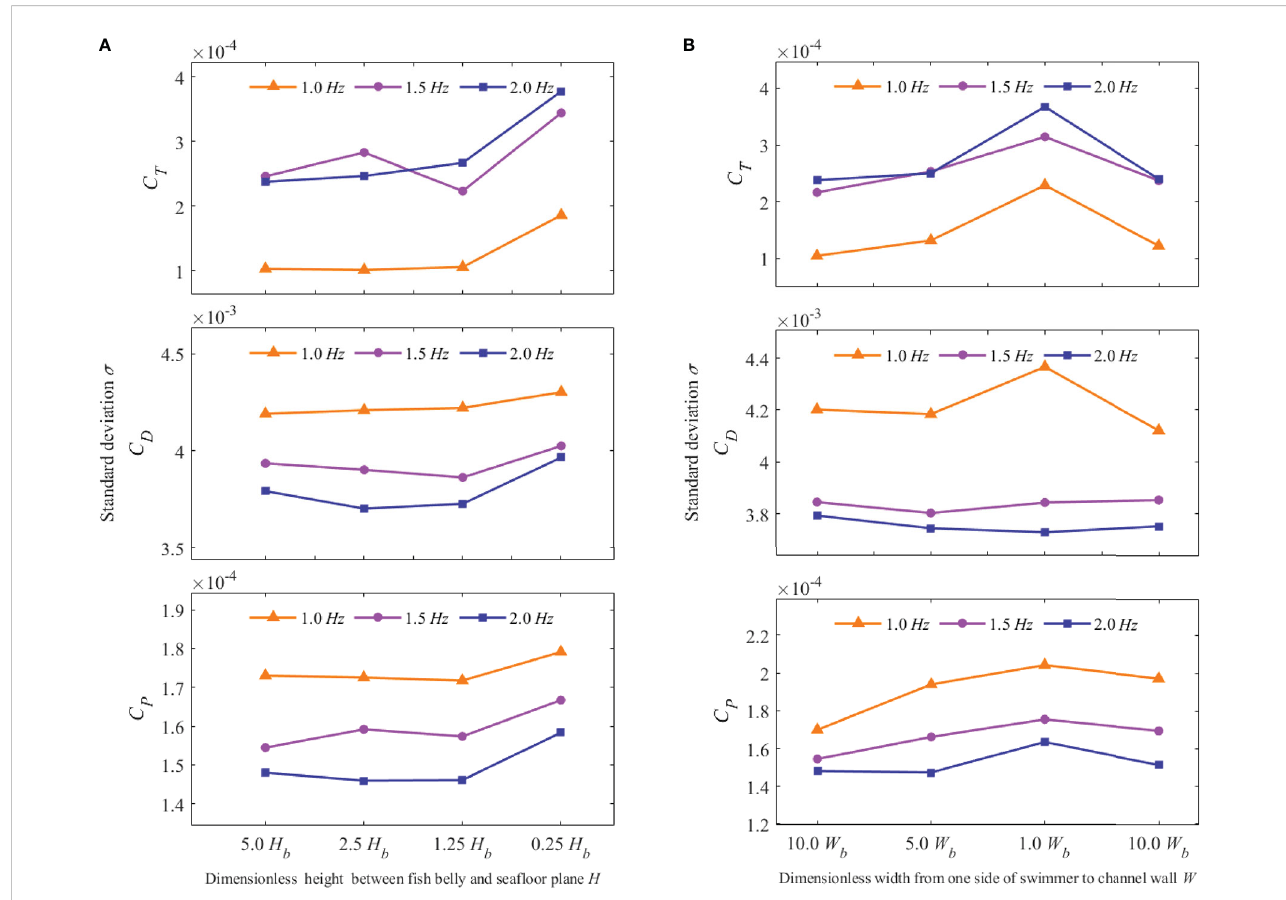
FIGURE 12 Hydrodynamic coef fi cient standard deviation of the swimmer at different values of f , H , and W . (A) Hydrodynamic coef fi cient standard deviation at different values of f and H (B) Hydrodynamic coef fi cient standard deviation at different values of f and